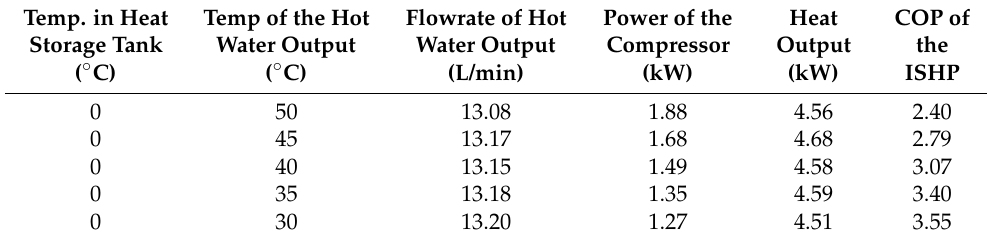
Table 1. Performance of the ISHP tested in the lab.